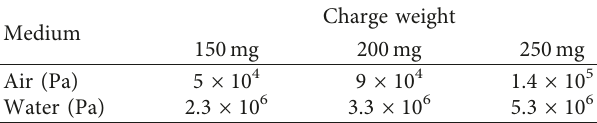
Table 2: Experimental quasi-static pressures.